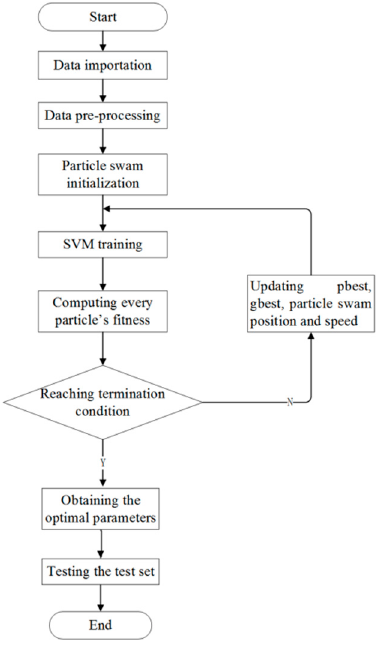
Figure 2. i SVM classification based on the particle swarm optimization. Figure 2. iSVM classification based on the particle swarm